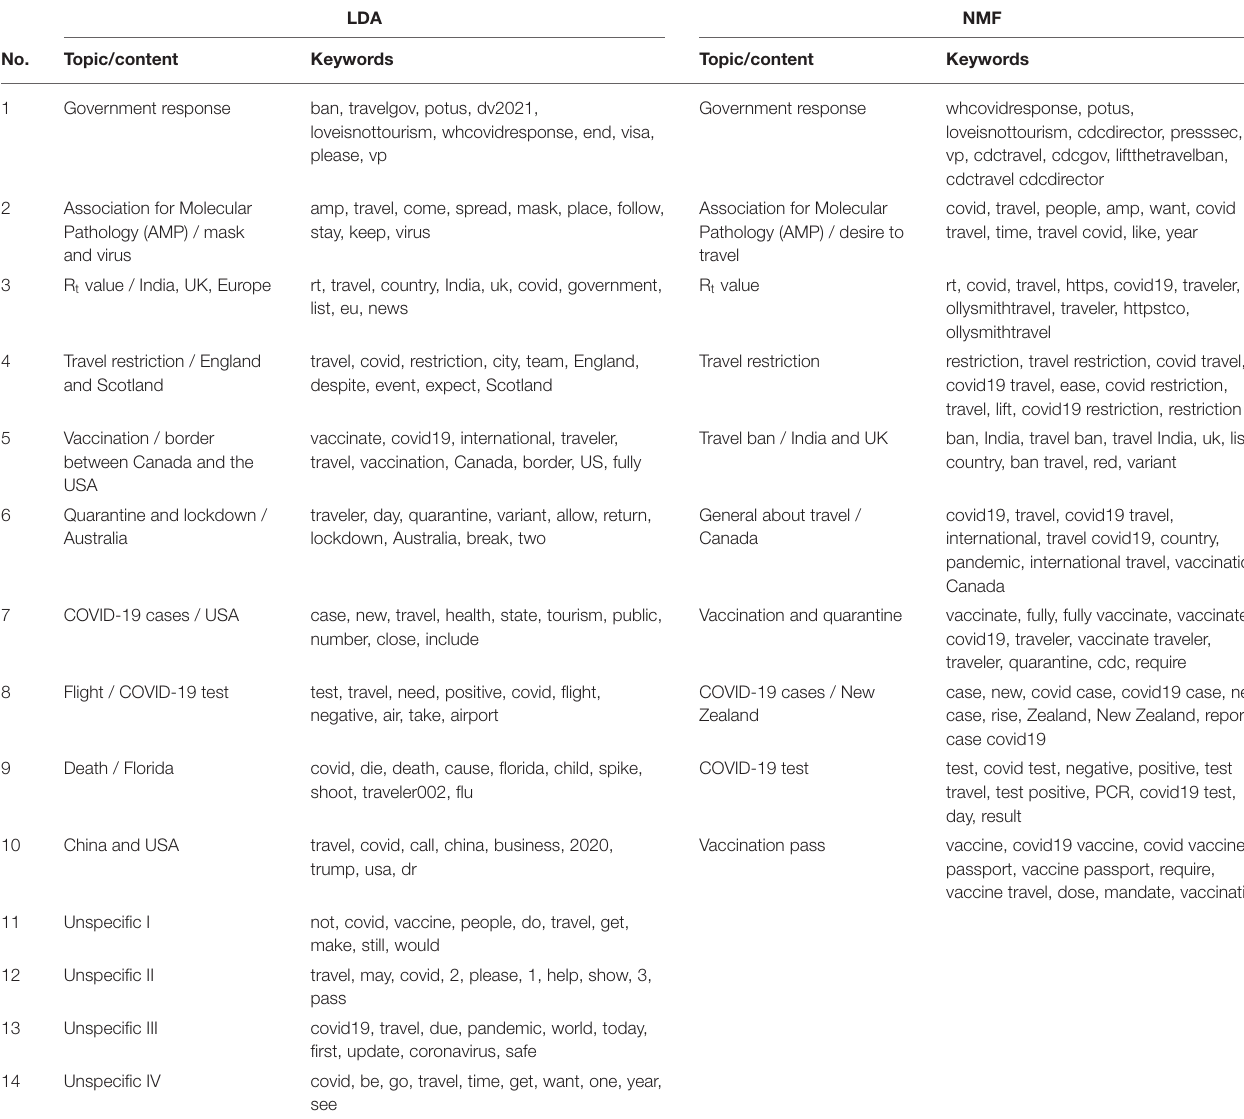
TABLE 1 | Topics identified by LDA and NMF.